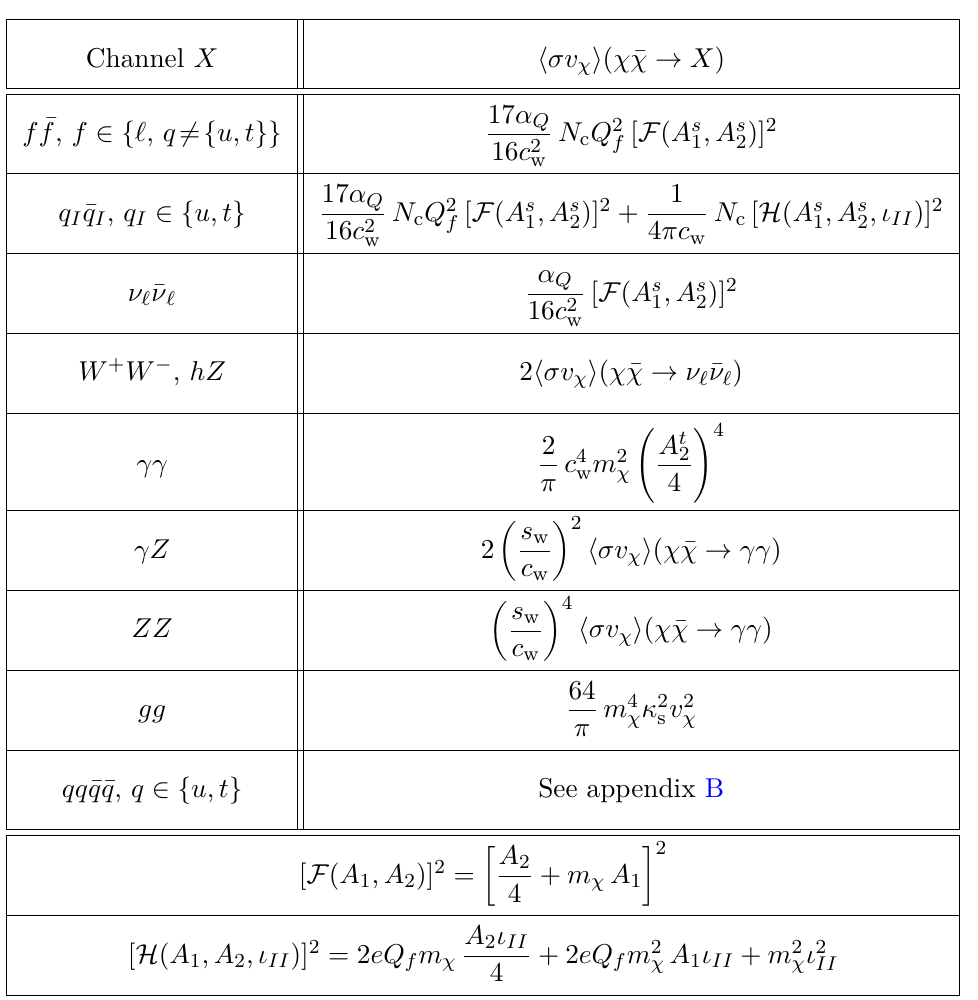
Table 3 . Analytic expressions for leading contributions to h σv i ( χ ¯ χ → X ) for a variety of SM final states X , in the limit of negligible SM